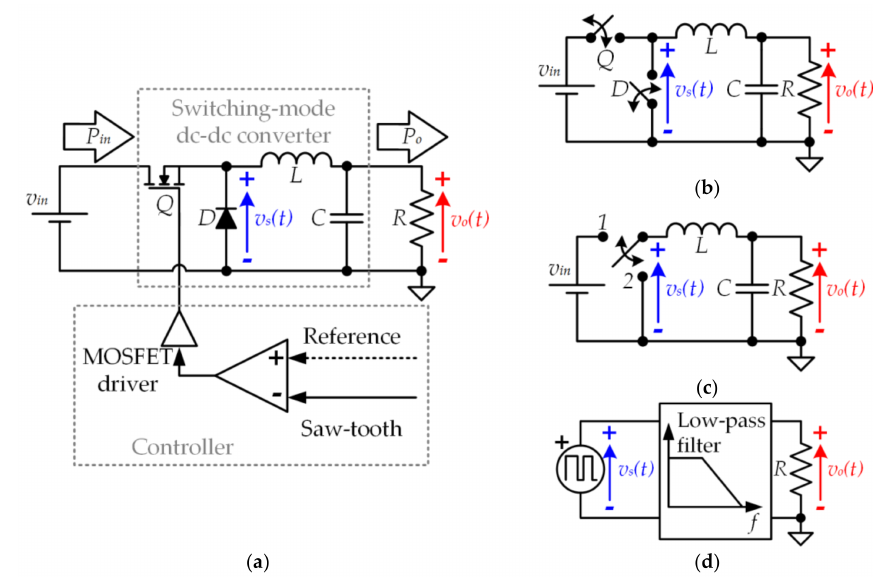
Figure 6. ( a ) Buck converter; ( b ) Equivalent circuit considering ideal complementary switches; ( c ) Equivalent circuit considering the two possible operating states; ( d ) The buck converter seen as a pulse-width modulator.